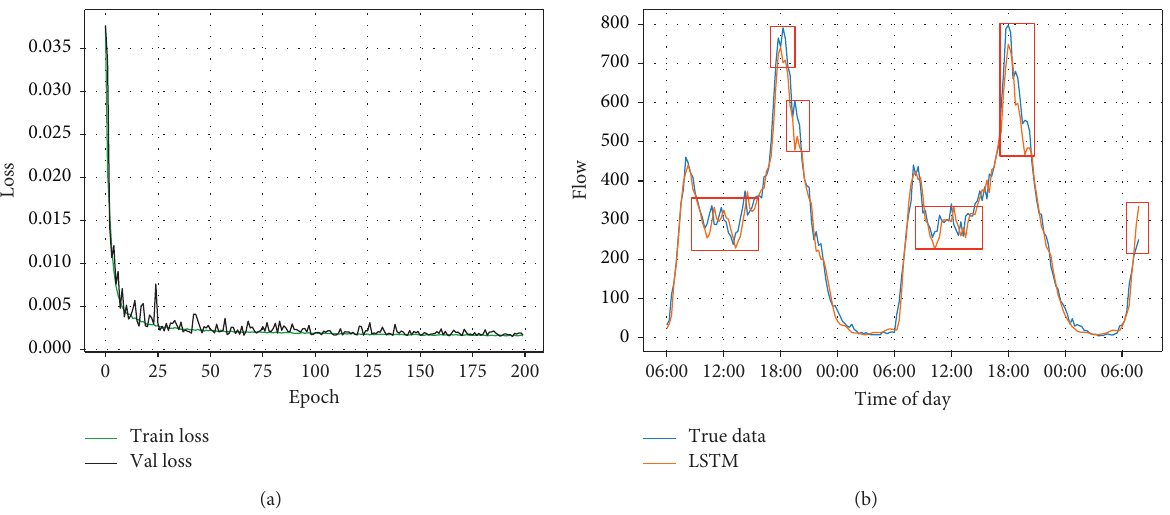
Figure 9: 8 steps LSTM training and prediction. (a) 8 steps LSTM loss function and (b) 8 steps LSTM prediction results.